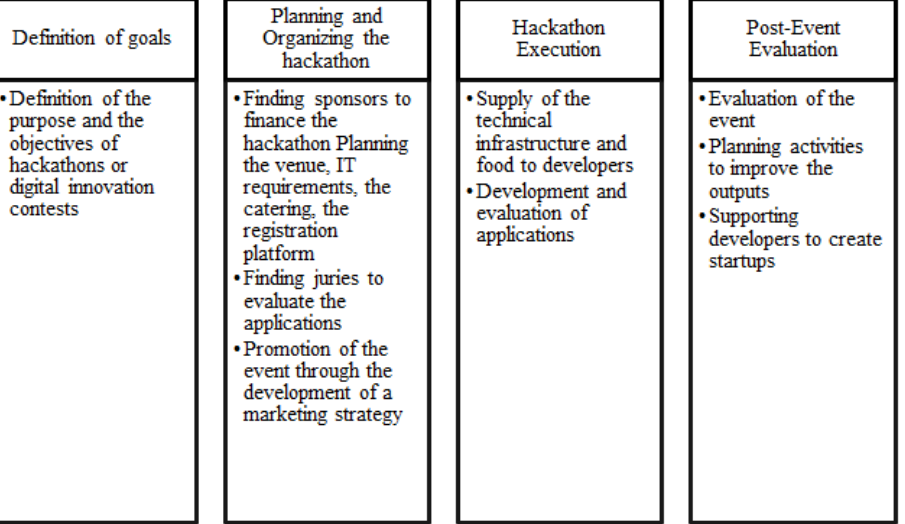
Figure 2. Phases and activities.